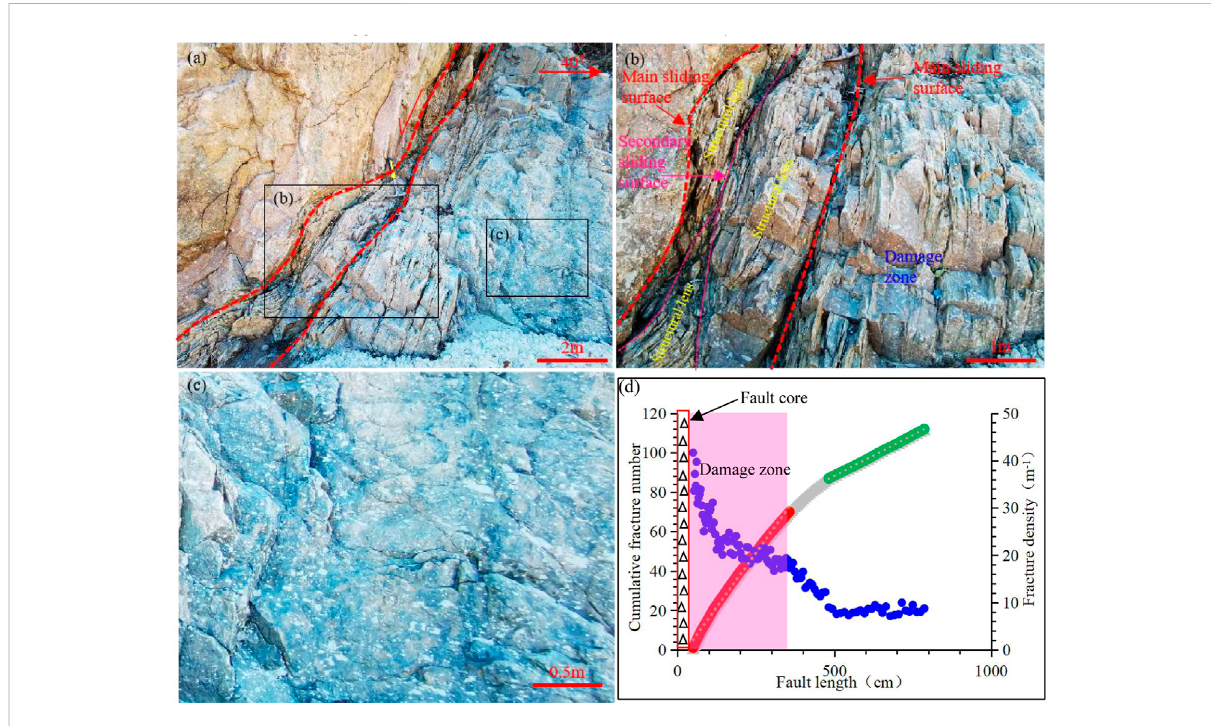
FIGURE 7 Internal structure of fault zone at Gushiyu village. (A) The overall characteristics of Gushiyu fault; (B) characteristics of the fault core; (C) characteristics of fracture development in the host rock; (D) distribution characteristics of fractures near